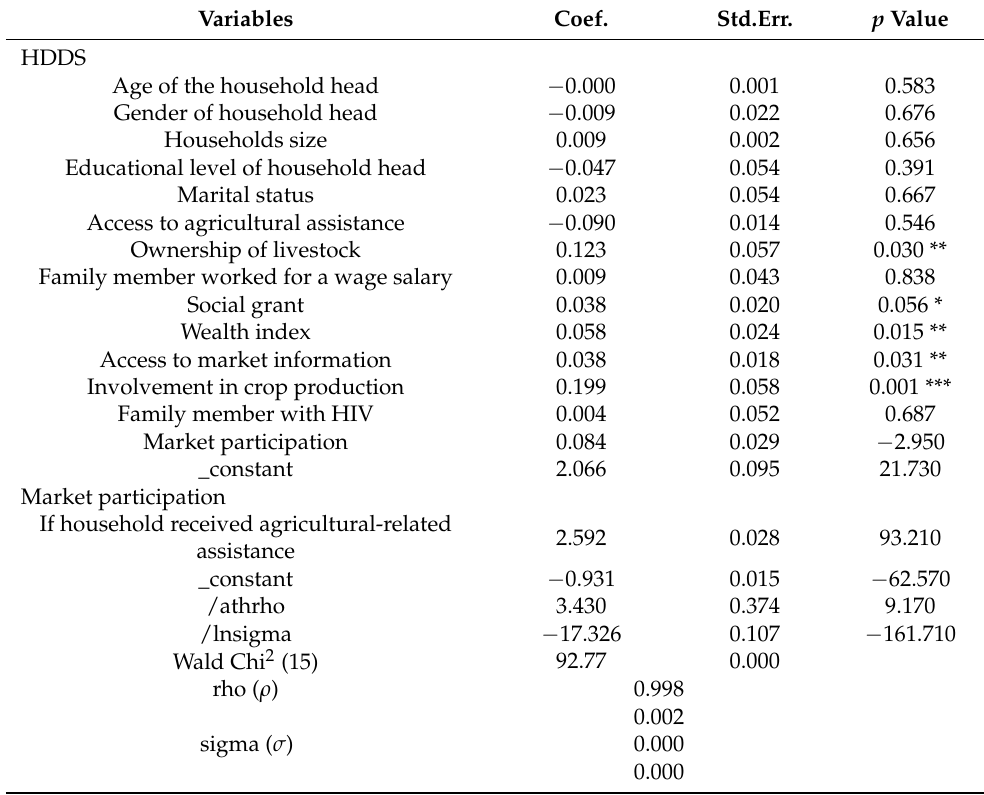
Table 4. Determinants of dietary diversity using Poisson regression with endogenous treatment. Variables Coef.